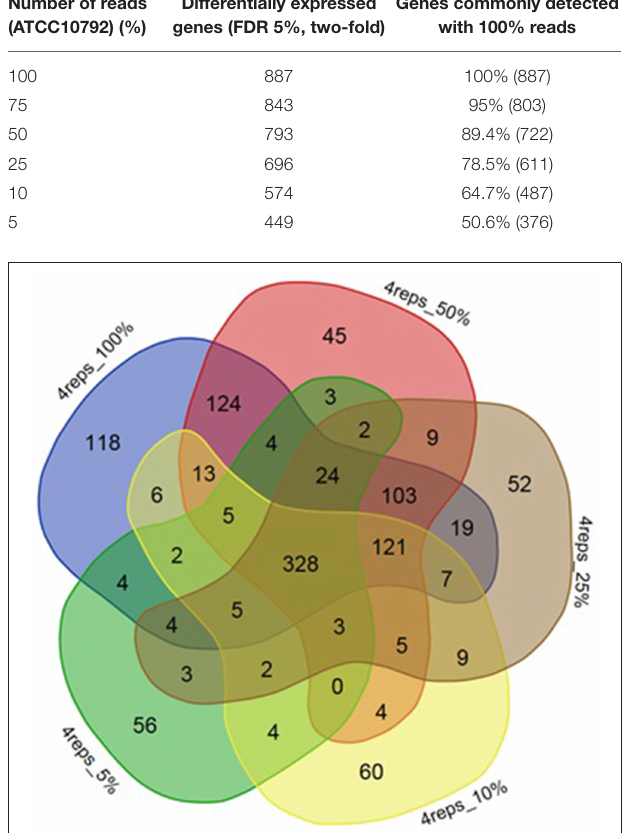
TABLE 5 | Effect of decreasing number of reads on significantly differentially expressed genes while maintaining all four replicates. Number of reads (ATCC10792) (%)